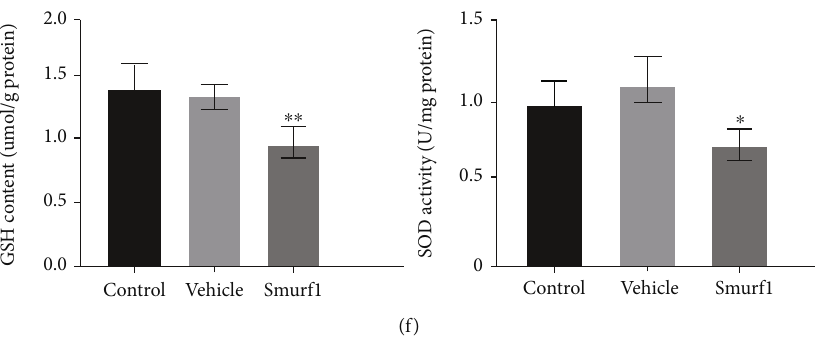
Figure 4: Smurf1 facilitated the fi brosis and oxidative stress of LF cells. (a, b) the transfection e ffi ciency of Smurf1 was analyzed by qRT- PCR and western-blot. ∗∗∗ p < 0 : 001 . (c, d) Western blotting and semiquanti fi cation for Collagen I, Collagen III, and α -SMA mRNA levels in the LF cells with or without Smuf1-OE). ∗∗ p < 0 : 01 . ∗∗∗ p < 0 : 001 . (e) The ROS levels and MDA content was assessed in the LF cells with or without Smuf1-OE. ∗ p < 0 : 05 . ∗∗ p < 0 : 01 . (f) the Glutathione (GSH) content, and Superoxide dismutase (SOD) activity was assessed in the LF cells with or without Smuf1-OE. ∗ p < 0 : 05 . ∗∗ p < 0 : 01 .